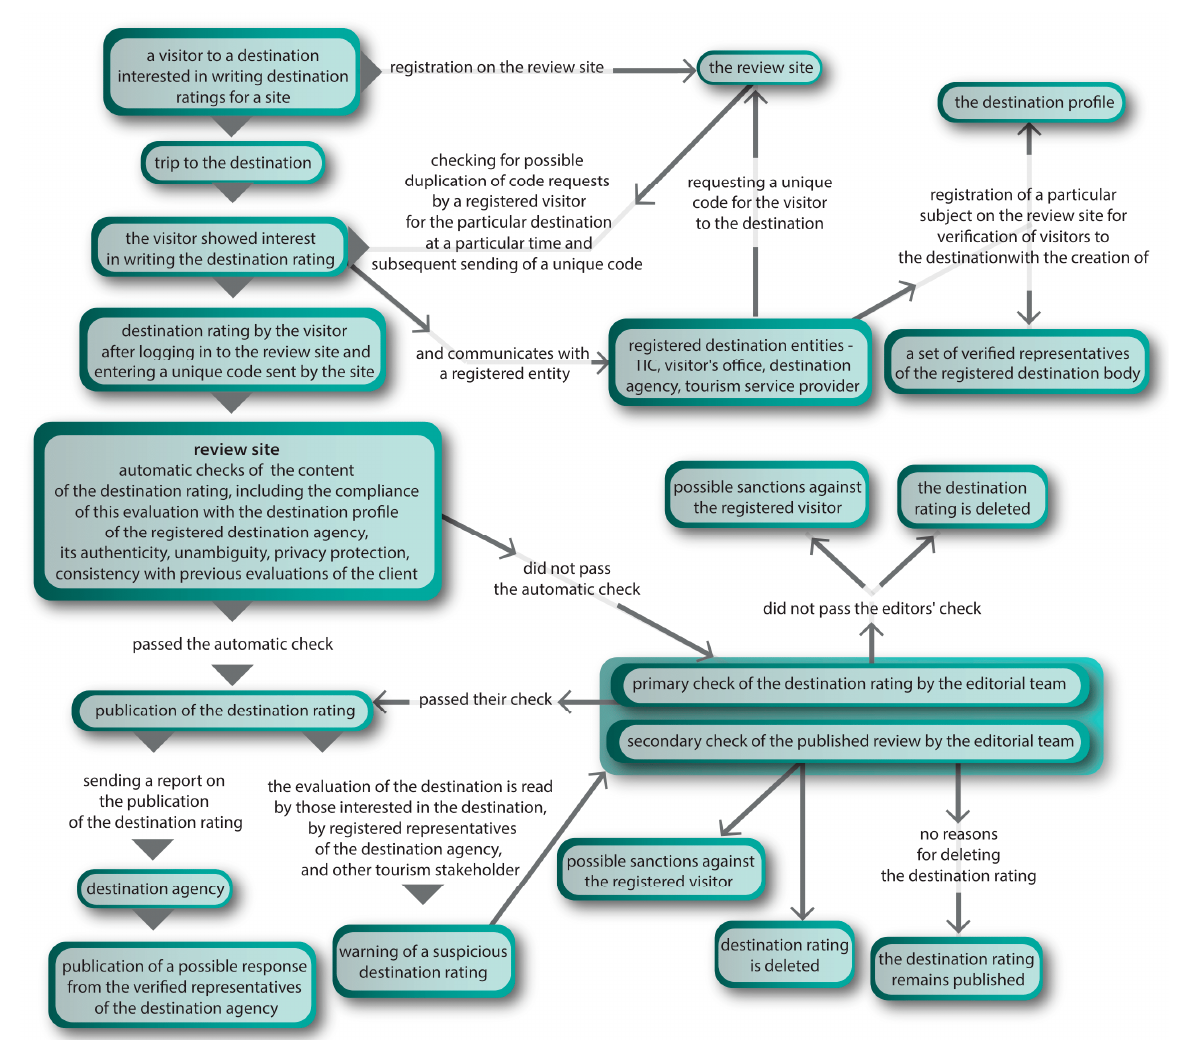
Figure 6. Process model of providing verified destination assessment.